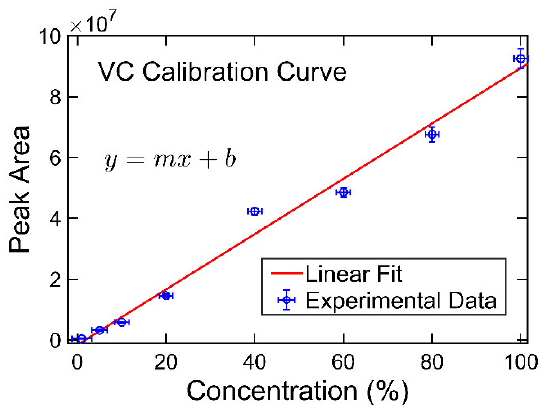
Figure 1. Calibration curve of vinylene carbonate (VC) with 95% confidence intervals.